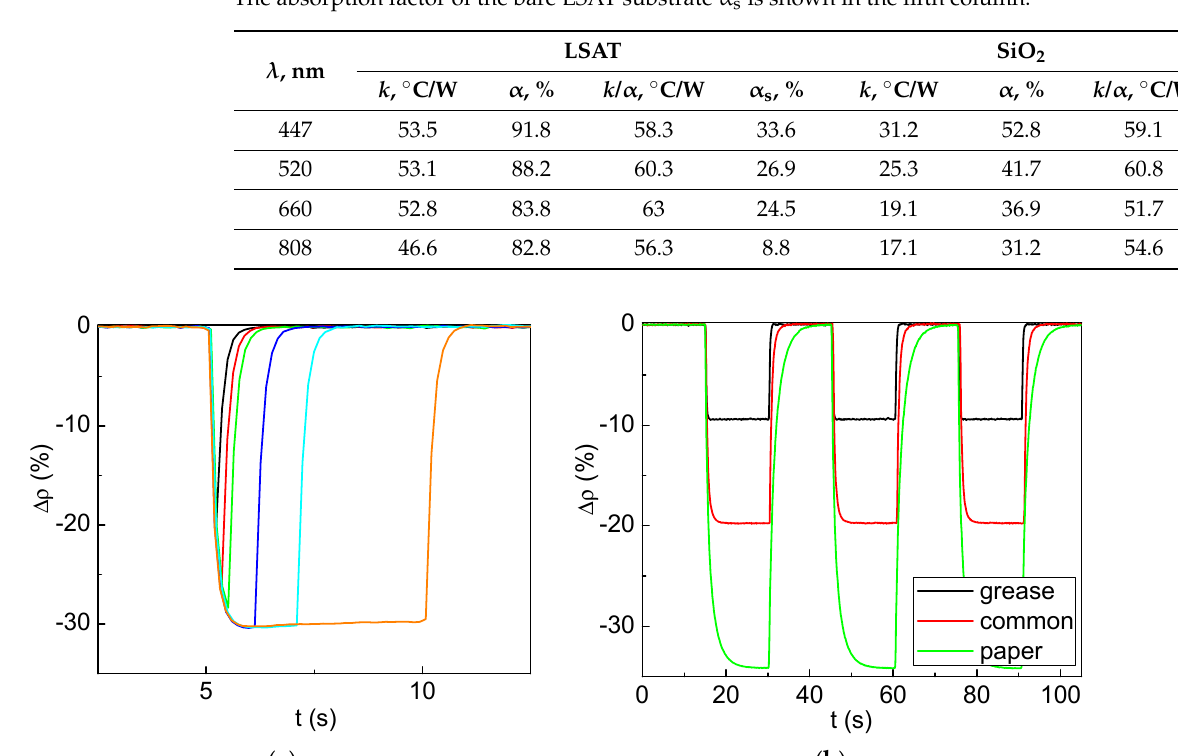
Figure 6. Estimated temperature increments as functions of the optical power for all light wavelengths with the corresponding linear fits for NNO films on ( a ) LSAT and ( b ) SiO 2 substrates. Table 1. The slope k of the linear fits Δ T ( P opt ) shown in Figure 6, the measured absorption factor α of the film-substrate stack and the ratio k / α for both NNO films and all light wavelengths λ . The absorption factor of the bare LSAT substrate α s is shown in the fifth column.